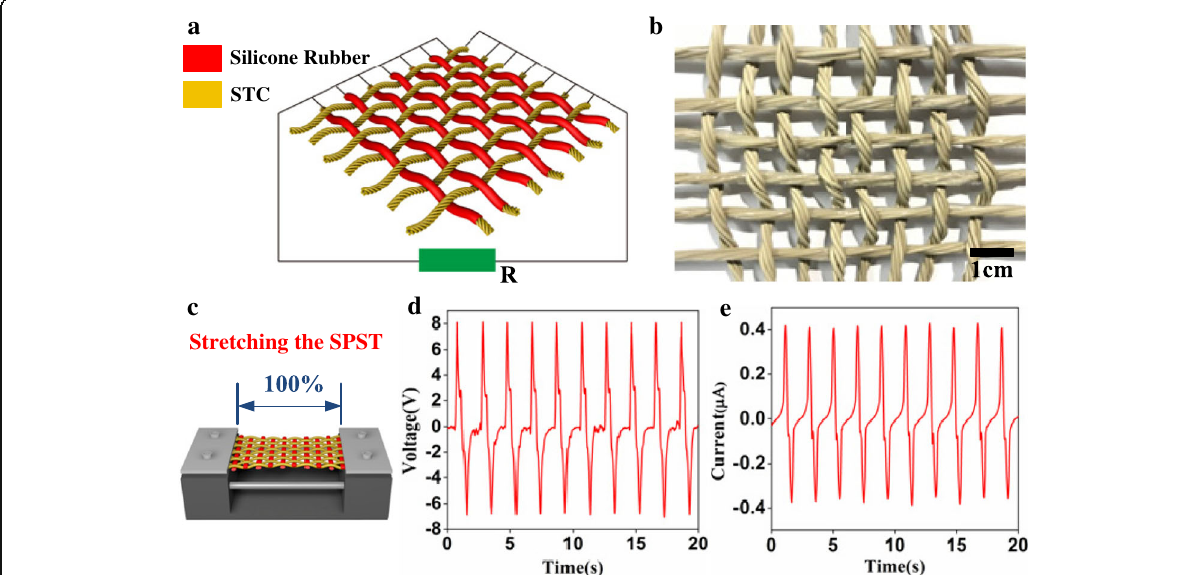
Fig. 3 a The schematic illustration of the SPST. b The photo image of the SPST. c The stretching schematic graph of the SPST at the 100% strain. d The output voltage and e output current of the SPST at the periodic stretching-releasing